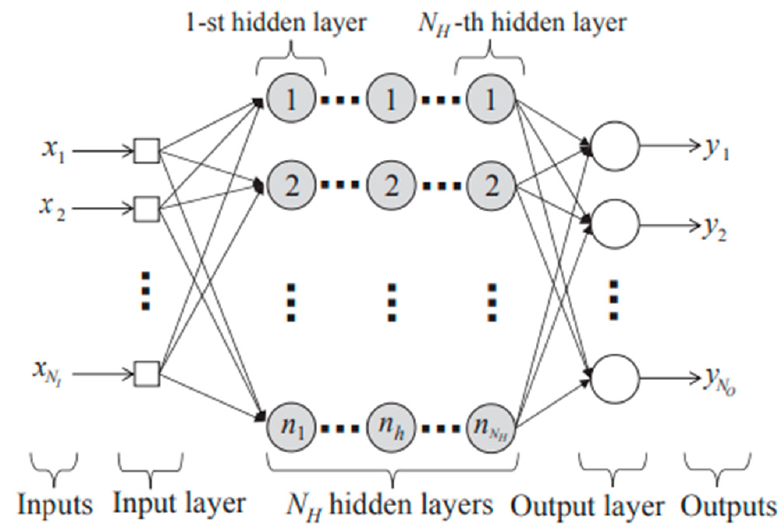
Figure 2. Multi-layer hidden layer feedforward ANN [78] .